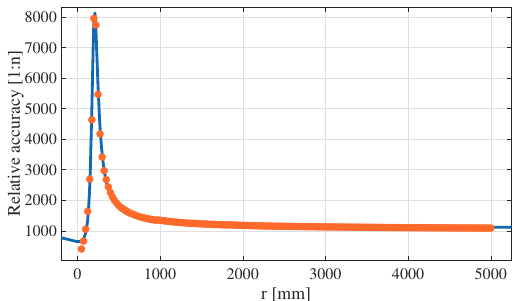
Figure 6. Exemplary data set (orange points) with adjusted second-degree rational function (blue line). r 2 = 0 .